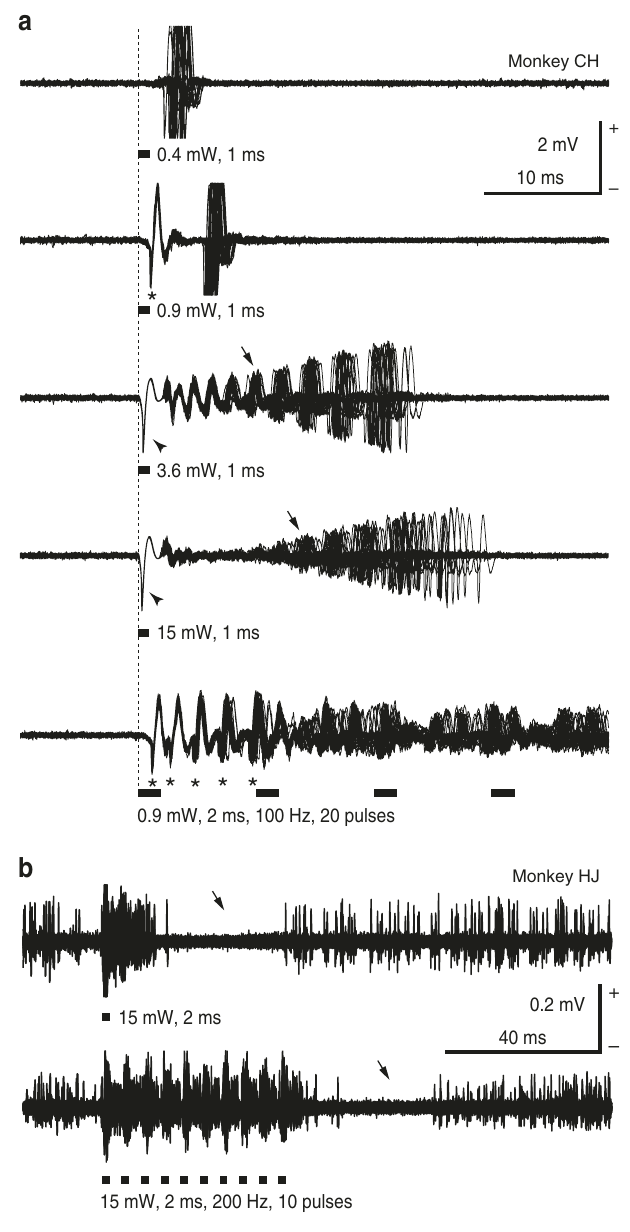
Fig. 2 Raw traces of M1 neuronal activity evoked by optogenetic intracortical microstimulation (oICMS). a An example of M1 neuronal activity induced by various intensities of single-pulse (0.4, 0.9, 3.6, 15 mW strength corresponding to 51, 115, 458, and 1910 mW/mm 2 , respectively, 1 ms pulse duration) and repetitive (0.9 mW corresponding to 115 mW/ mm 2 , 2 ms, 100 Hz, 20 pulses) oICMS. The neuronal activity from one and the same neuron probably located in layer 5 was recorded, and 30 traces are overlaid. A vertical dashed line and thick black horizontal lines indicate the beginning and duration of light illumination, respectively. *Action potentials at a short and constant latency that were most likely evoked directly; arrowheads, de fl ections from the baseline that were composed of population spikes of multiple neurons and/or local fi eld potentials occurring at the same time; arrows, deteriorated action potentials that were truncated due to long-lasting depolarization. Note that no spikes were observed before stimulation, suggesting that the recording neuron was not injured by the optrode. b Another example of M1 neuronal activity induced by single- pulse (15 mW corresponding to 1910 mW/mm 2 , 2 ms) and repetitive (15 mW, 2 ms, 200 Hz, 10 pulses) oICMS shown on a long time scale. Multi-unit activity was recorded probably in layer 5. Excitation induced by oICMS was followed by inhibition